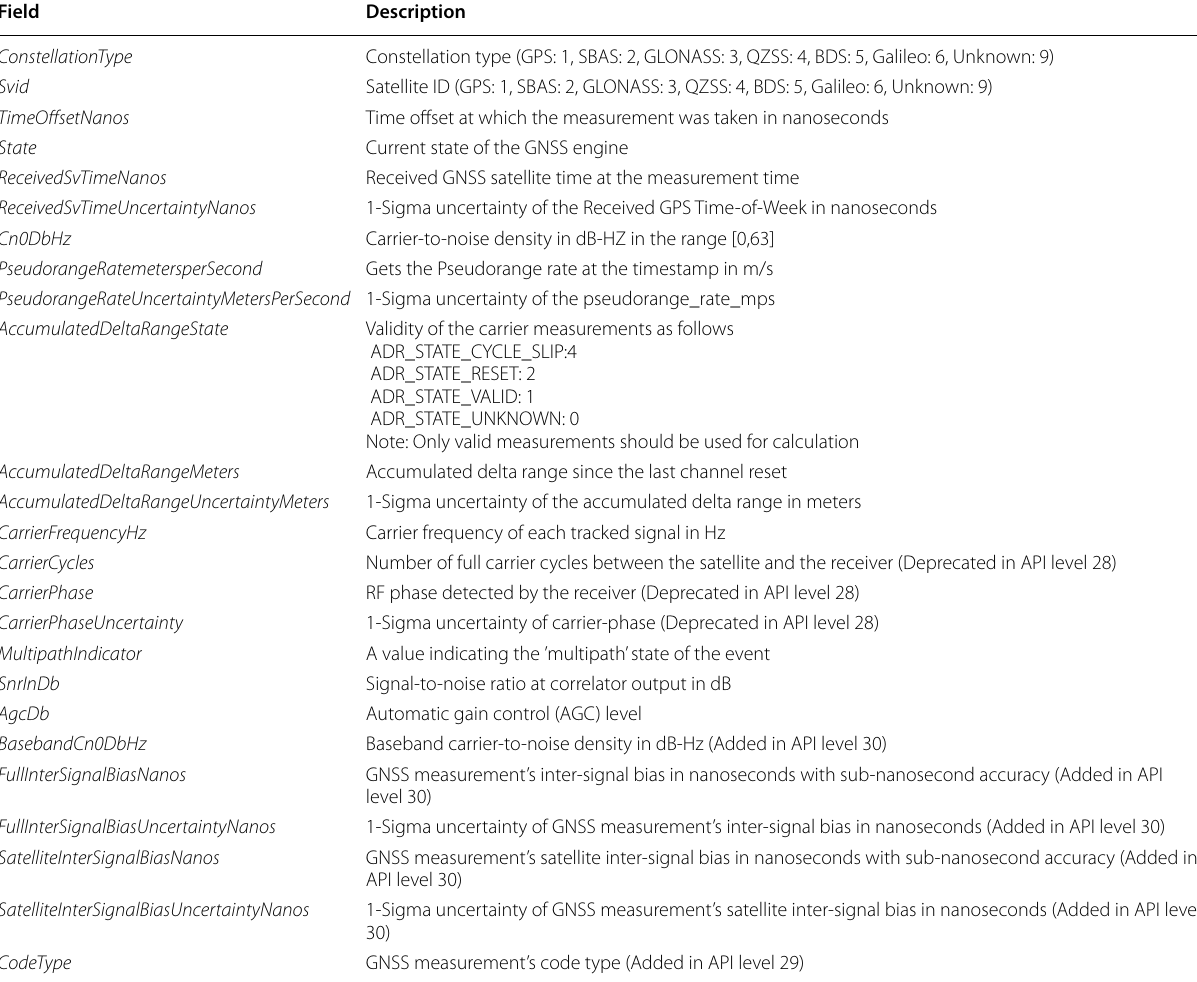
Table 2 List of variables from GNSSMeasurement class within the Android API package “location” (European GSA, 2018b) Field